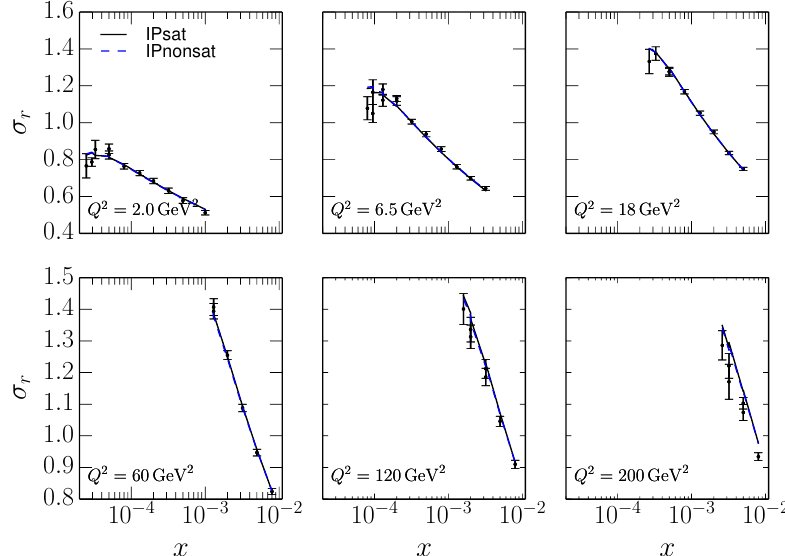
Figure 15. IPsat and IPnonsat (linearized IPsat) independent fits to inclusive reduced cross section HERA data. Both fits result in almost indistinguishable results, hindering the extraction of a signal of gluon saturation at HERA. Figure from